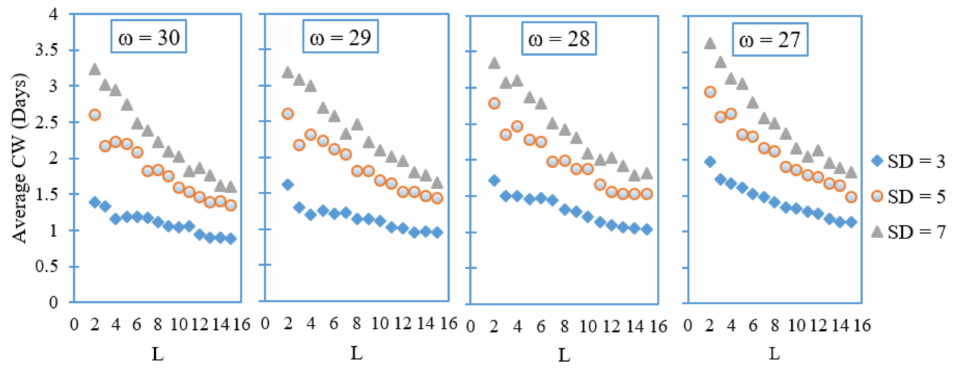
Figure 4. Average CW per order for different L, ω , and SD